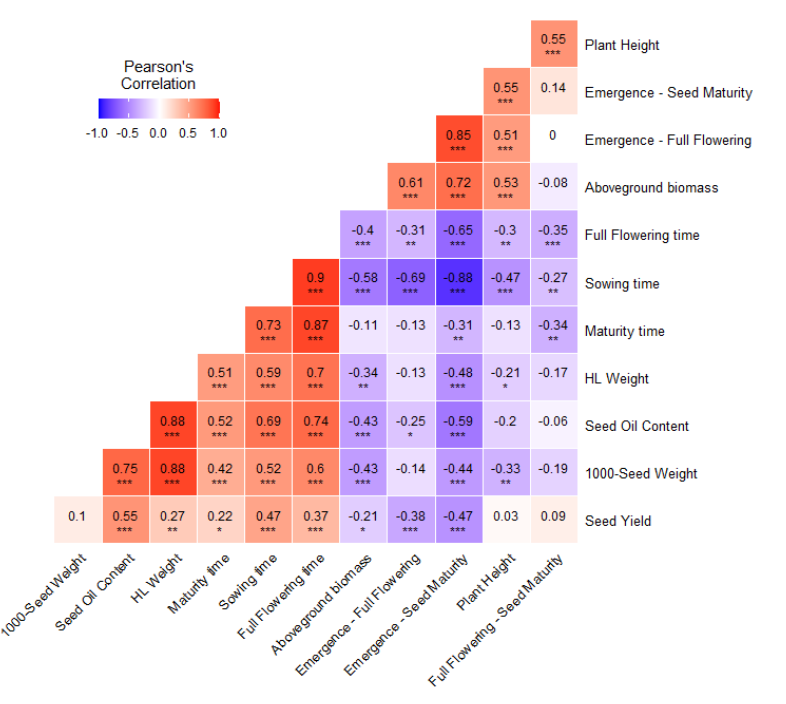
Figure 5. Trait correlations heat maps (*, ** and *** Significant at the p < 0.05, 0.01 and 0.001 levels, respectively).